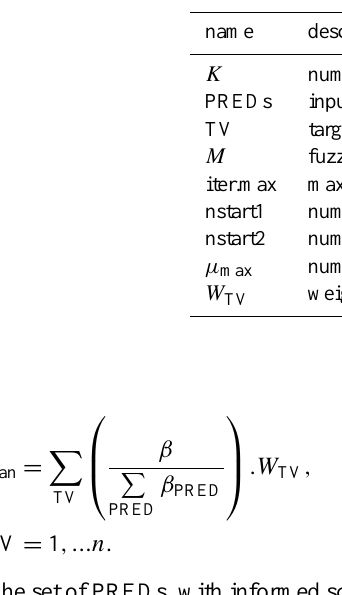
Fig. 4. (a) Visualisation of 128 samples generated by TopoSUB. (b) Polar plot showing the distribution of samples in terms of predictors used: elevation, aspect, slope and sky view factor. Table 2. Parameters used in